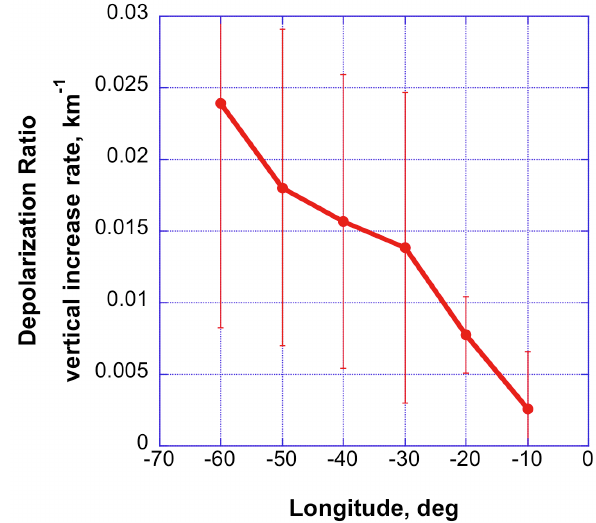
Fig. 6. Rate of vertical increase in dust depolarization ratio between Figure 6. Rate of vertical increase in dust depolarization ratio between 3 km and 4 km 2 3 and 4km altitudes, vs. distance from the African coast, repre- altitudes, vs. distance from the African coast, represented by longitude. Particle shape-3 sented by longitude. Particle shape-dependent differences in fall dependent differences in fall speed cause increasingly more pronounced vertical stratification 4 speed cause increasingly more pronounced vertical stratification as plumes move as plumes move westward. 5